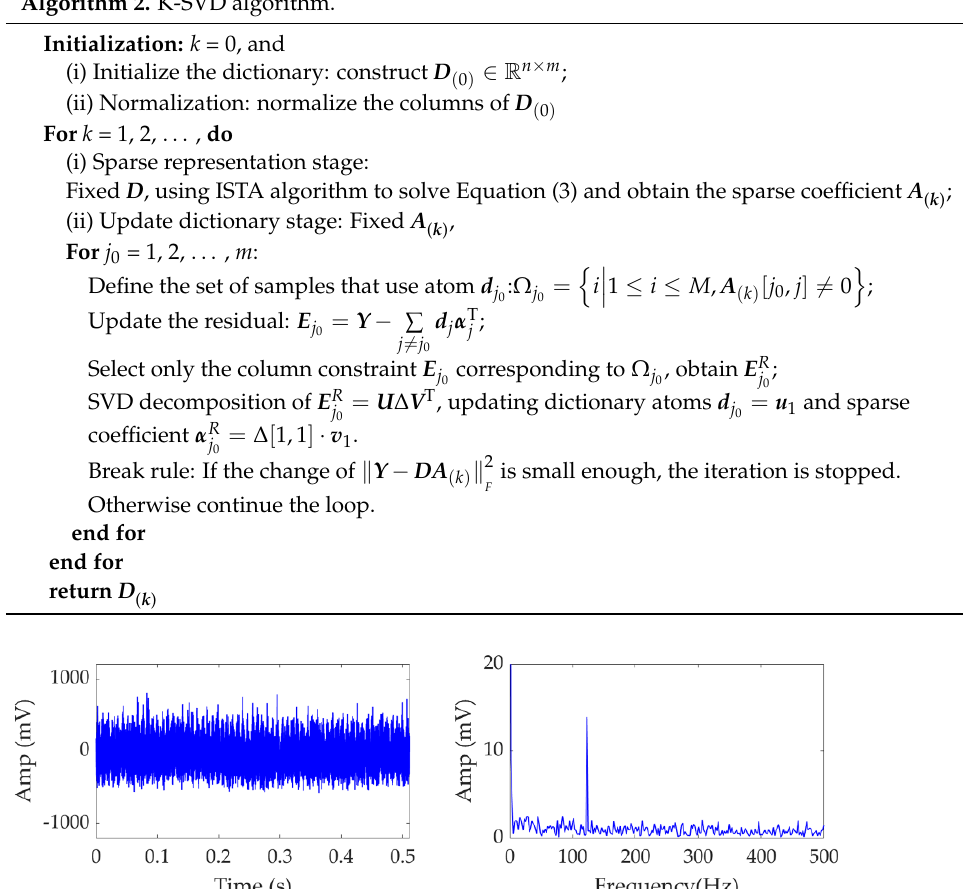
Algorithm 2. K-SVD algorithm.